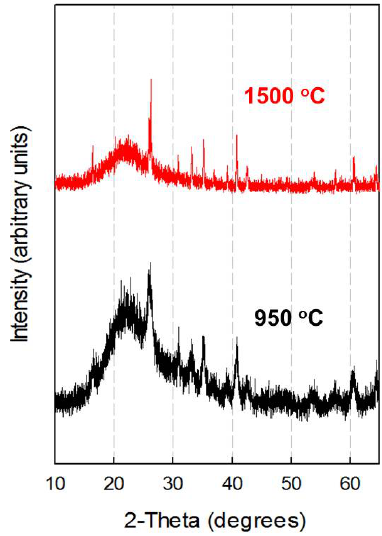
Figure 4. Comparison of XRD patterns of mullite-silica composites calcined at 950 ◦ C and 1500 ◦ C.